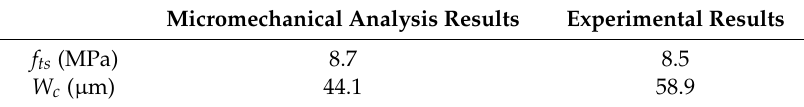
Table 6. Comparison between micromechanical analysis and experimental